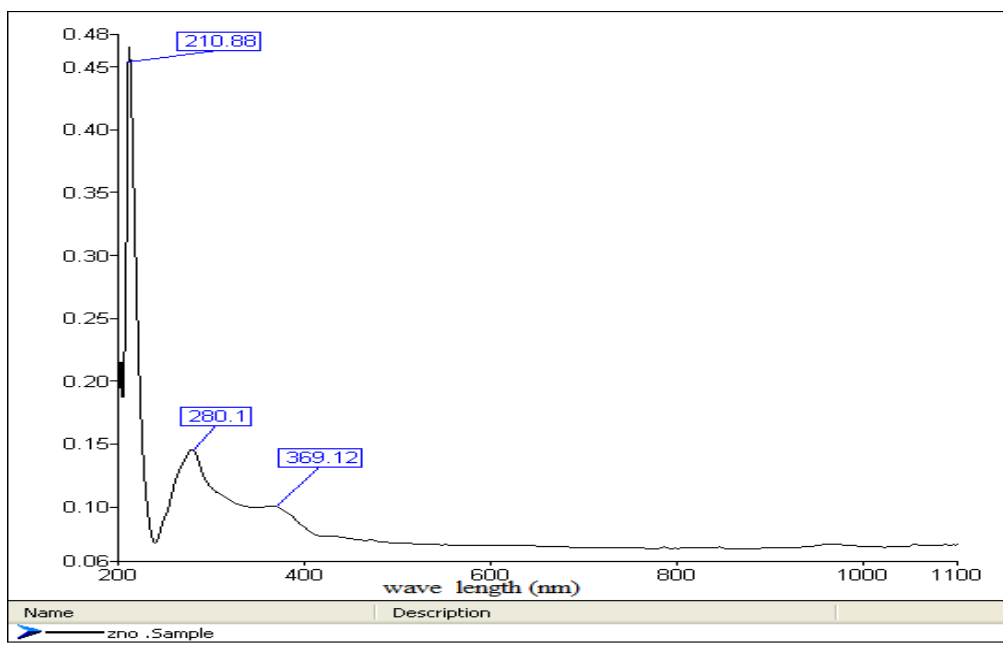
Figure 3. UV-visible absorption spectroscopy of ZnONPs synthesis shows SPR effect at 369.12